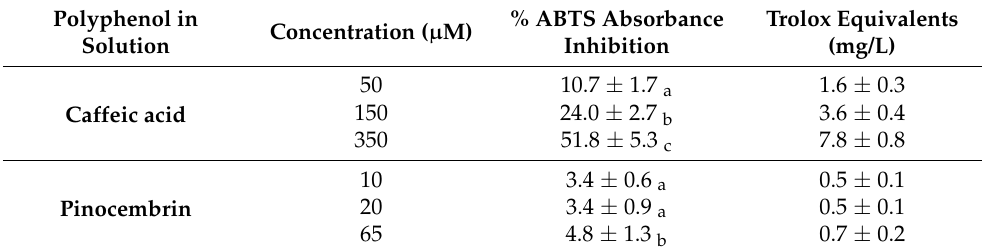
Table 1. Antioxidant capacity of caffeic acid and pinocembrin in